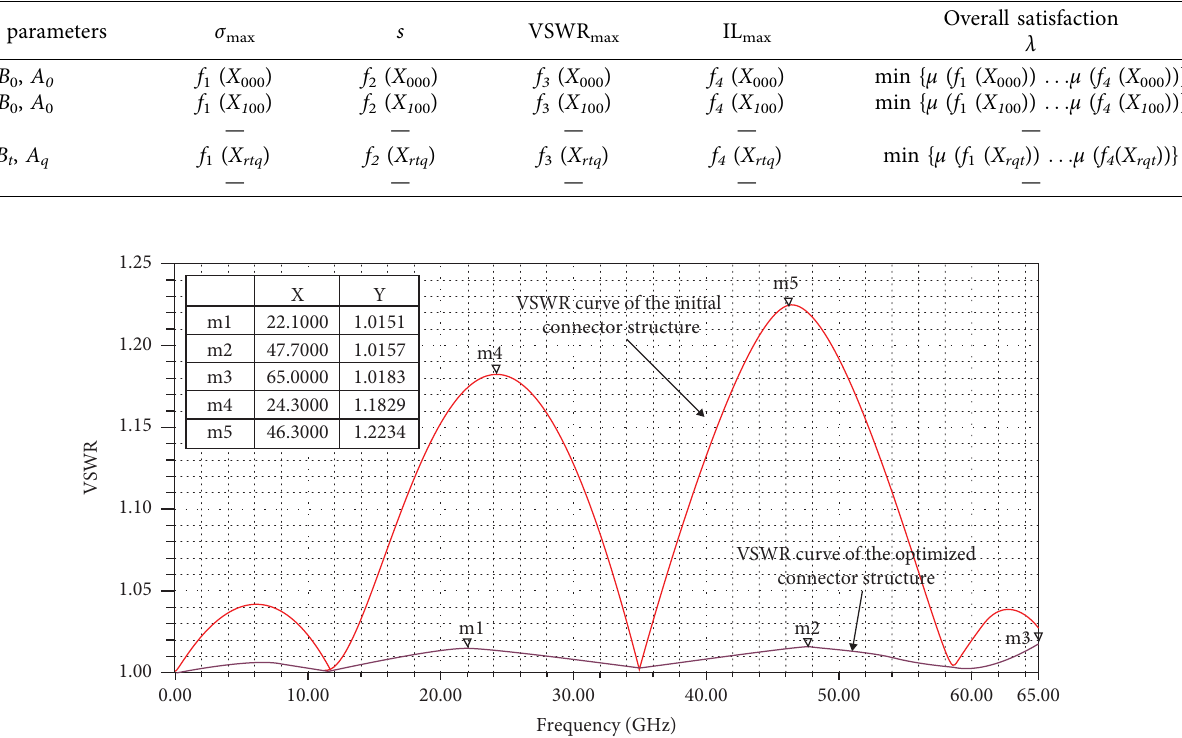
Figure 6: Comparison of the connector’s VSWR curves before and after optimization.